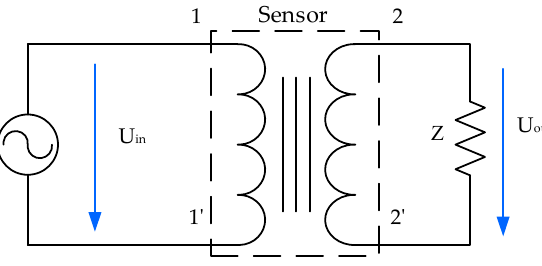
Figure 5. Frequency response analysis test equipment connections in the fluid core double coil sensor.